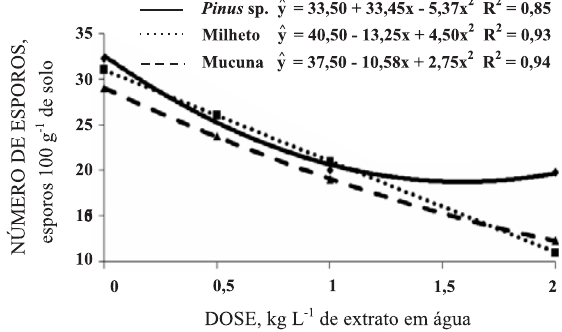
Figura 3. Índice de velocidade de germinação e percentagem de germinação de feijão em função da aplicação das quatro doses de extrato aquoso de Pinus , milheto e mucuna, em condições de germinador, por sete dias a 25 °C; médias de quatro